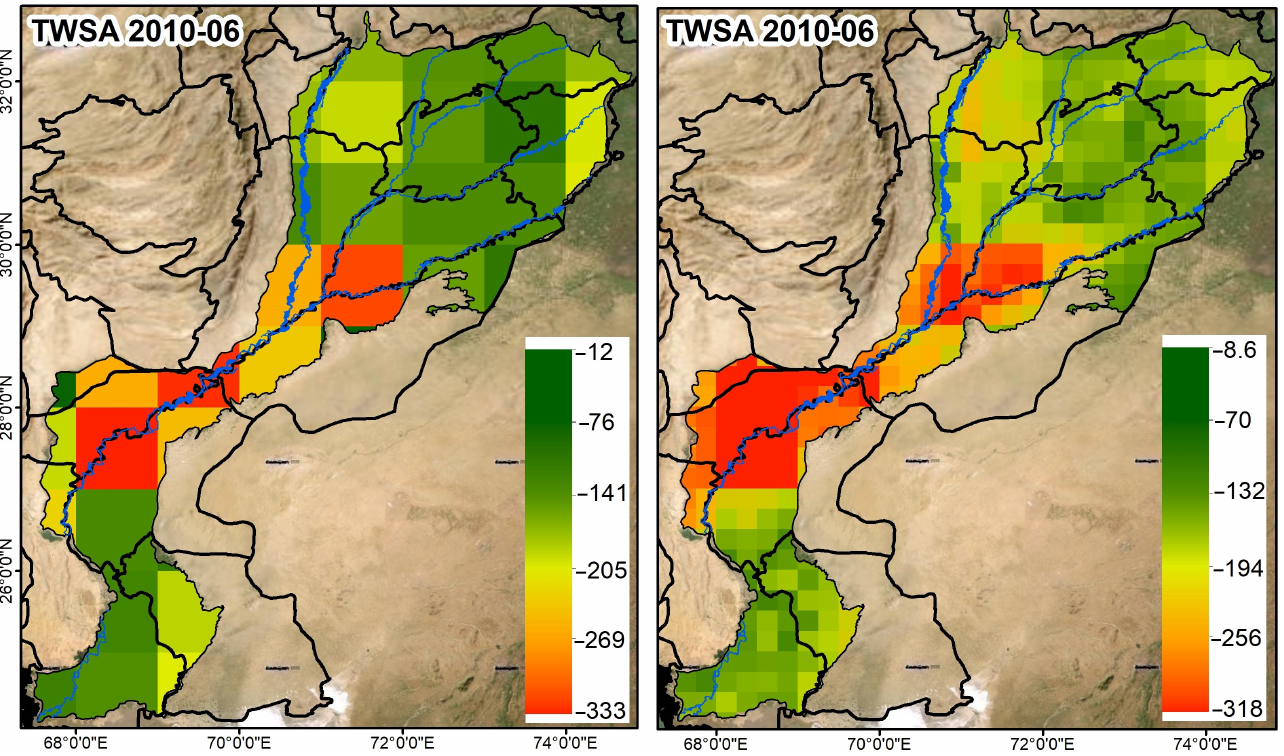
Figure 6. TWSA (mm) spatial changes before (left) and after (right) downscaling in June 2010.